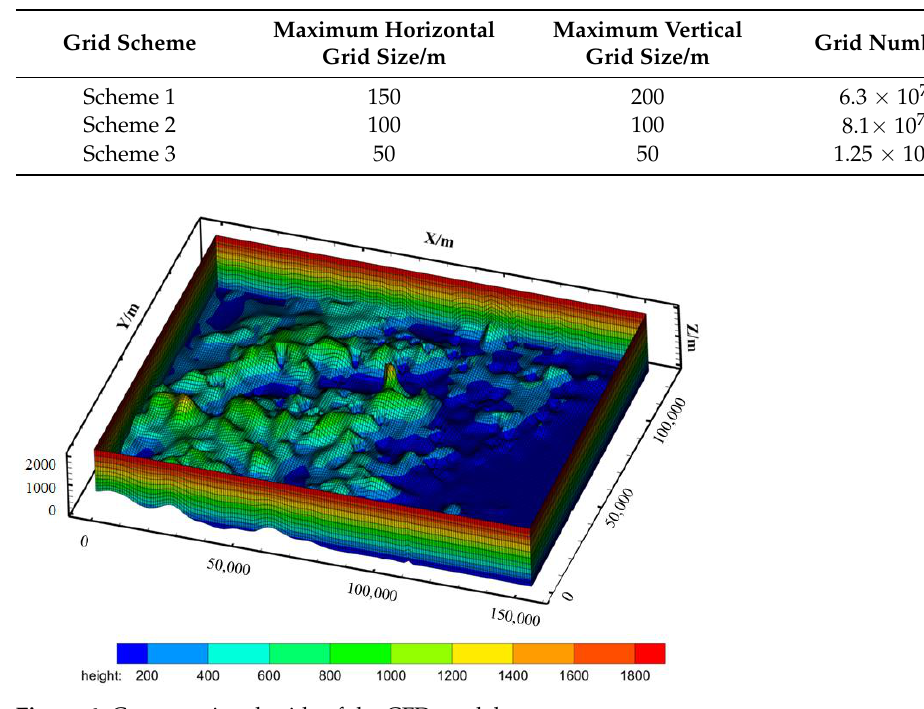
Figure 6. Computational grids of the CFD model. Table 4. Grid sensitivity analysis